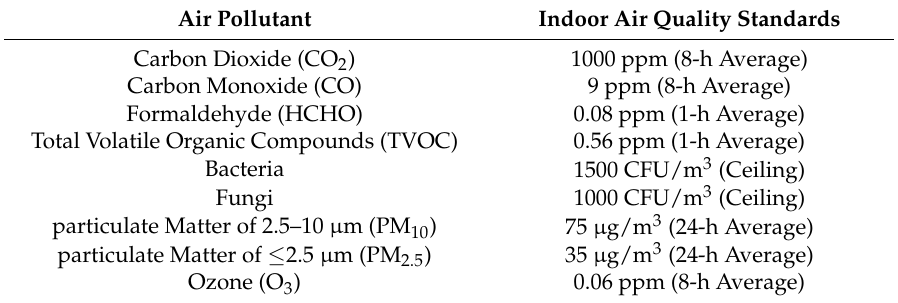
Table 1. The stipulated standards of Taiwan’s indoor air quality management act